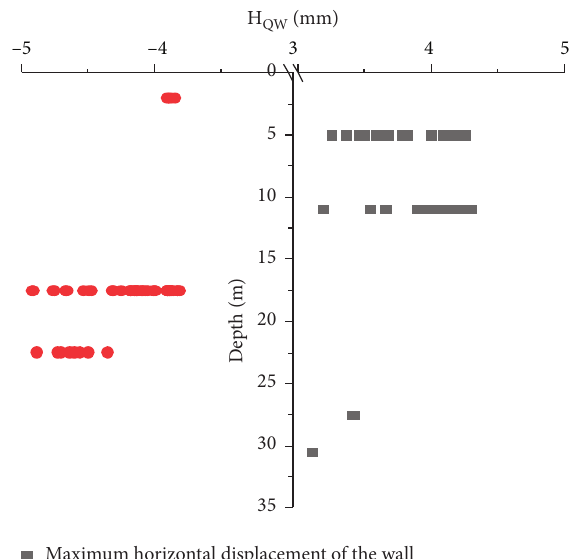
Figure 16: Distribution of the maximum and minimum horizontal displacement of the ground connecting